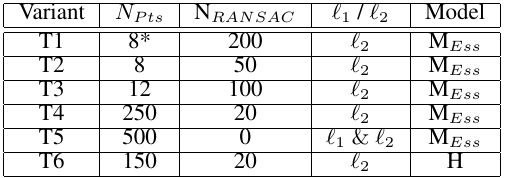
Table 1. Six variants to calculate the pairwise relative motions. M Ess is the 8-point essential matrix algorithm, H is the homo- graphy decomposed to a relative motion (Faugeras and Lustman, 1988). (*) indicates that the points were drawn with a bias forcing a homogenous distribution within the